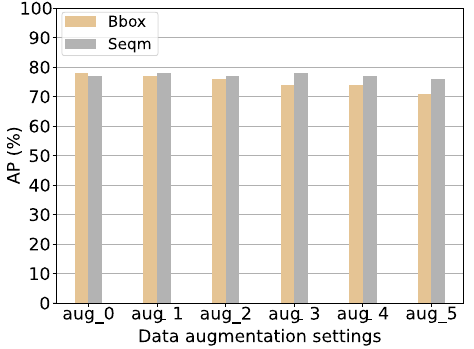
Figure 20. Average precision of categories individually with different levels of data augmentation enabled. ( Left ) AP for bounding boxes. ( Right ) AP for segmentation.